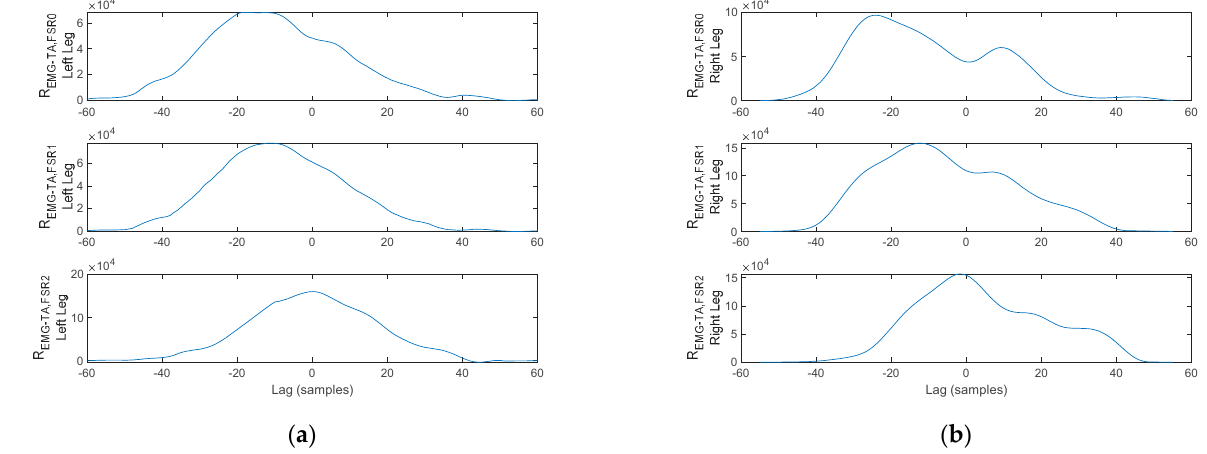
Figure 19. Cross-correlation of the TA and FSR signals plotted in Figure 17 for the ( a ) left foot and ( b ) right foot.